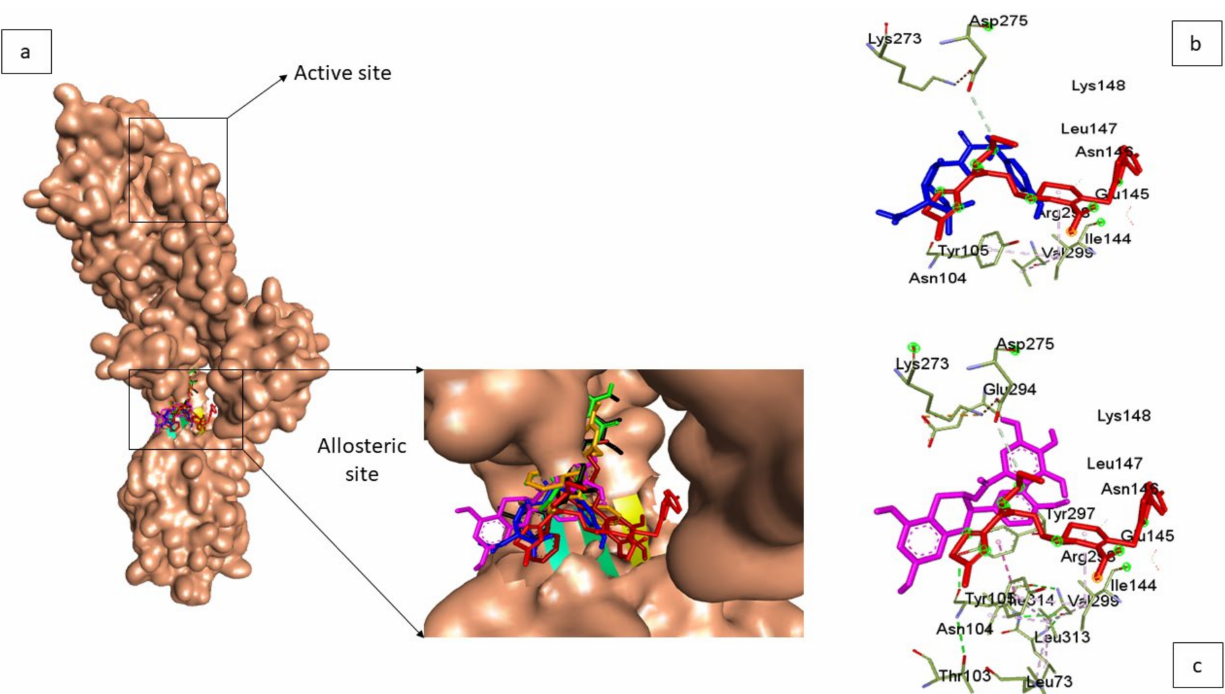
Figure 3. ( a ) Superimposition at the allosteric site of the co-crystal structure of PBP2a from S. aureus (3ZFZ), demonstrating the capability of the top-five phenolics (chroman-4-one (green), epicatechin gallate (purple), epigallocatechin 4-benzylthioether (brown), propan-2-one (pink), silicristin (black) and amoxicillin (blue)) to achieve the same orientation with the native inhibitor of 3ZFZ (red) with a low RMSD value of <1. ( b , c ) showed the superimposition of epicatechin gallate (phenolic with the highest docking score) and amoxicillin (antibiotic with the highest docking score) with the native inhibitor of 3ZFZ, displaying the amino acid at the allosteric site of PBP2a of S. aureus (located 60 Å away from the active site)